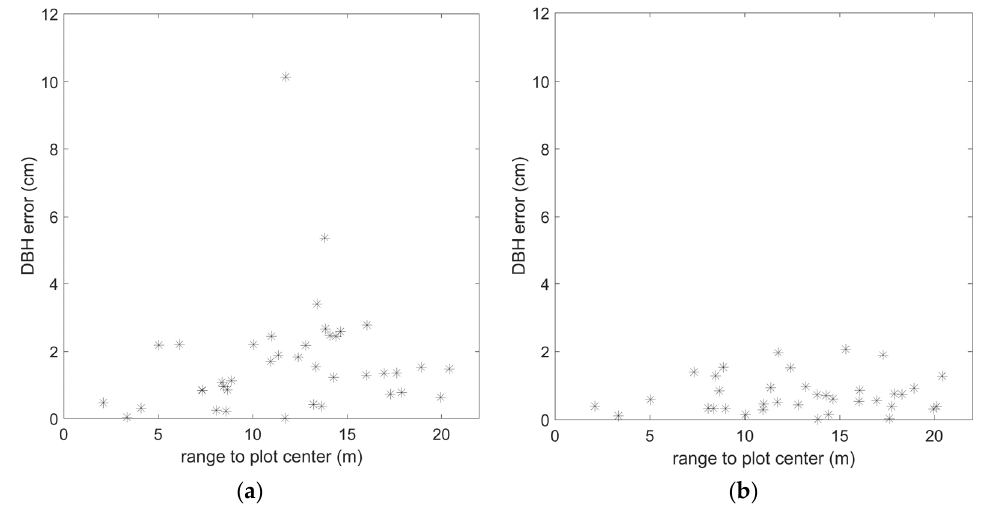
Figure 9. Scatter plot between range and DBH error: ( a ) from single scan (SS); ( b ) from MS. Here, error is defined as the absolute difference between the measured ground truth and the extracted.